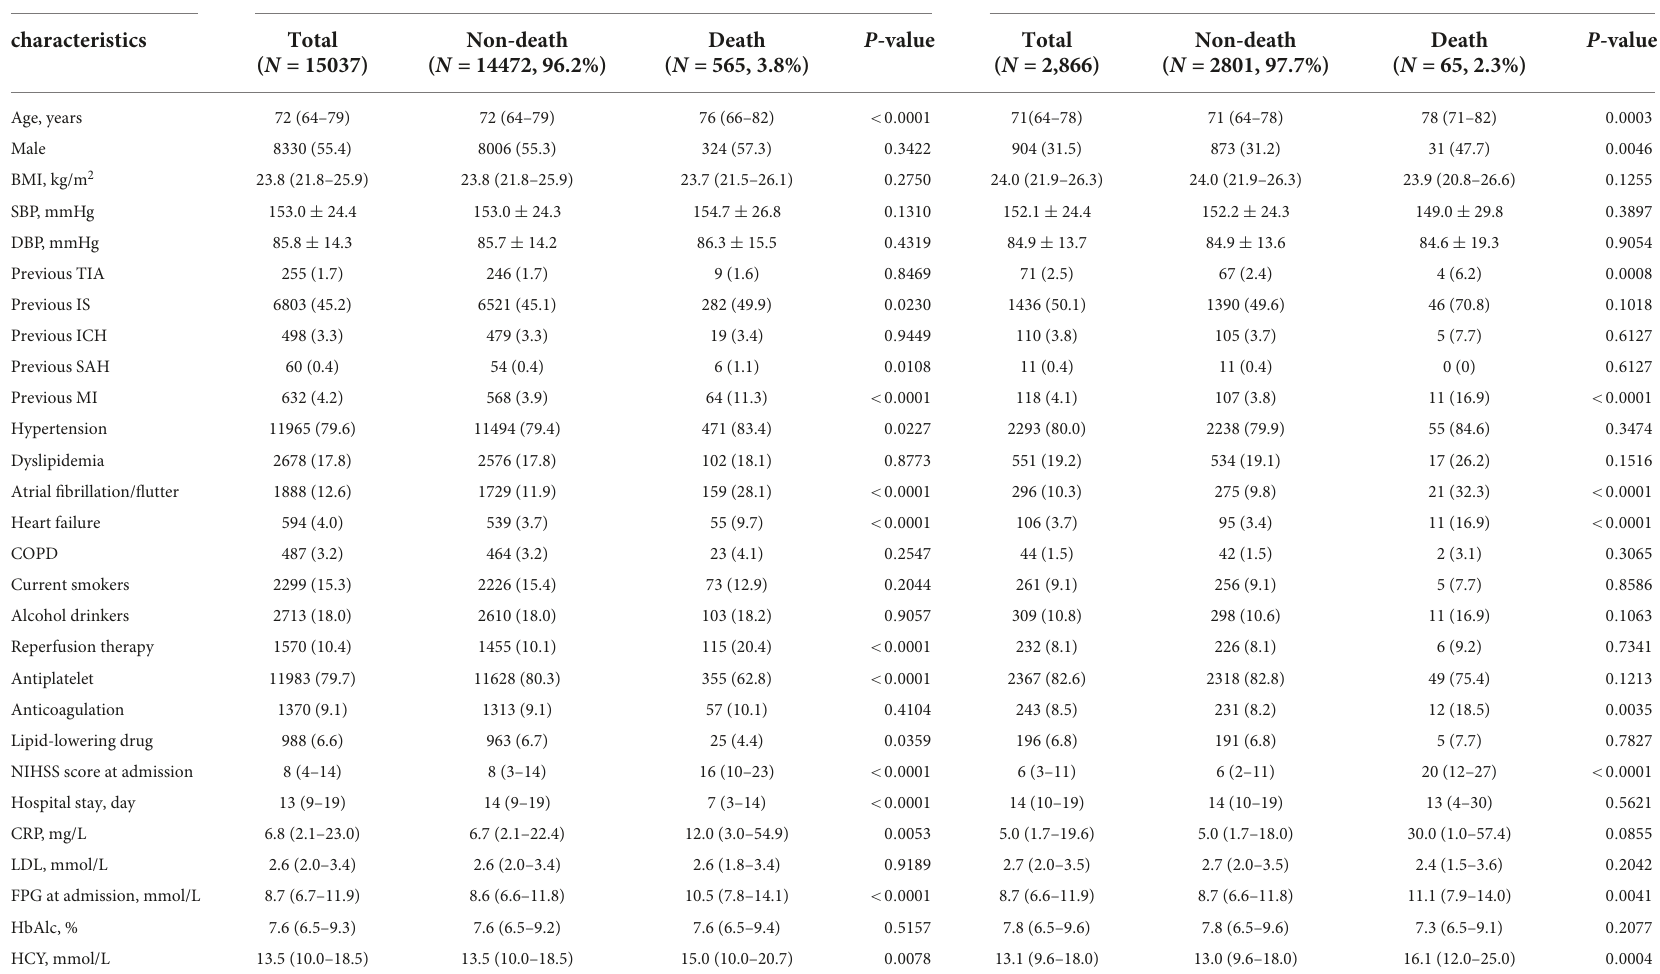
TABLE 4 Clinical features after infection in patients with pneumonia or urinary tract